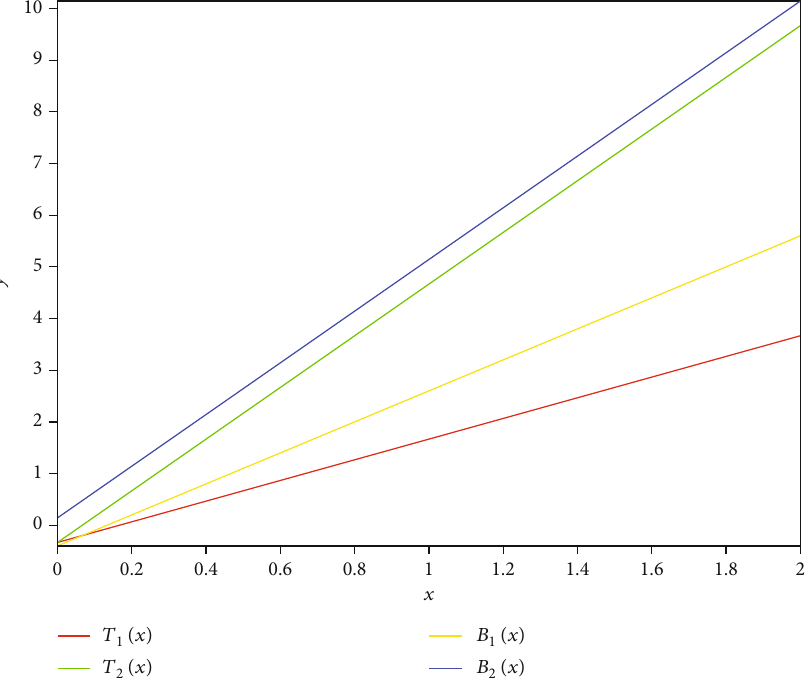
Figure 1: Graphical behaviour of T